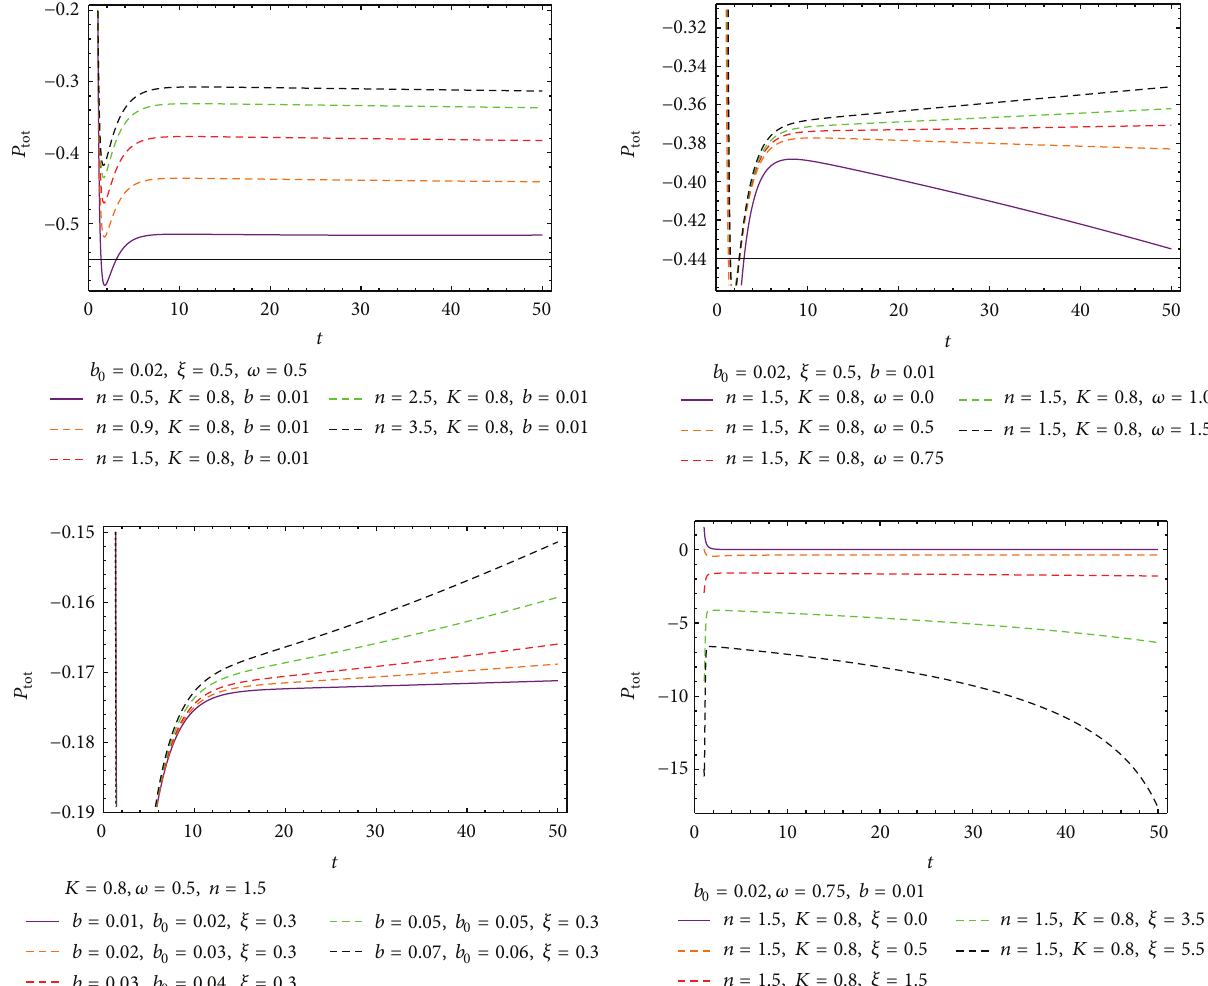
Figure 12: Behavior of 𝑃 against 𝑡 for interacting barotropic fluid and viscous polytropic gas. tot